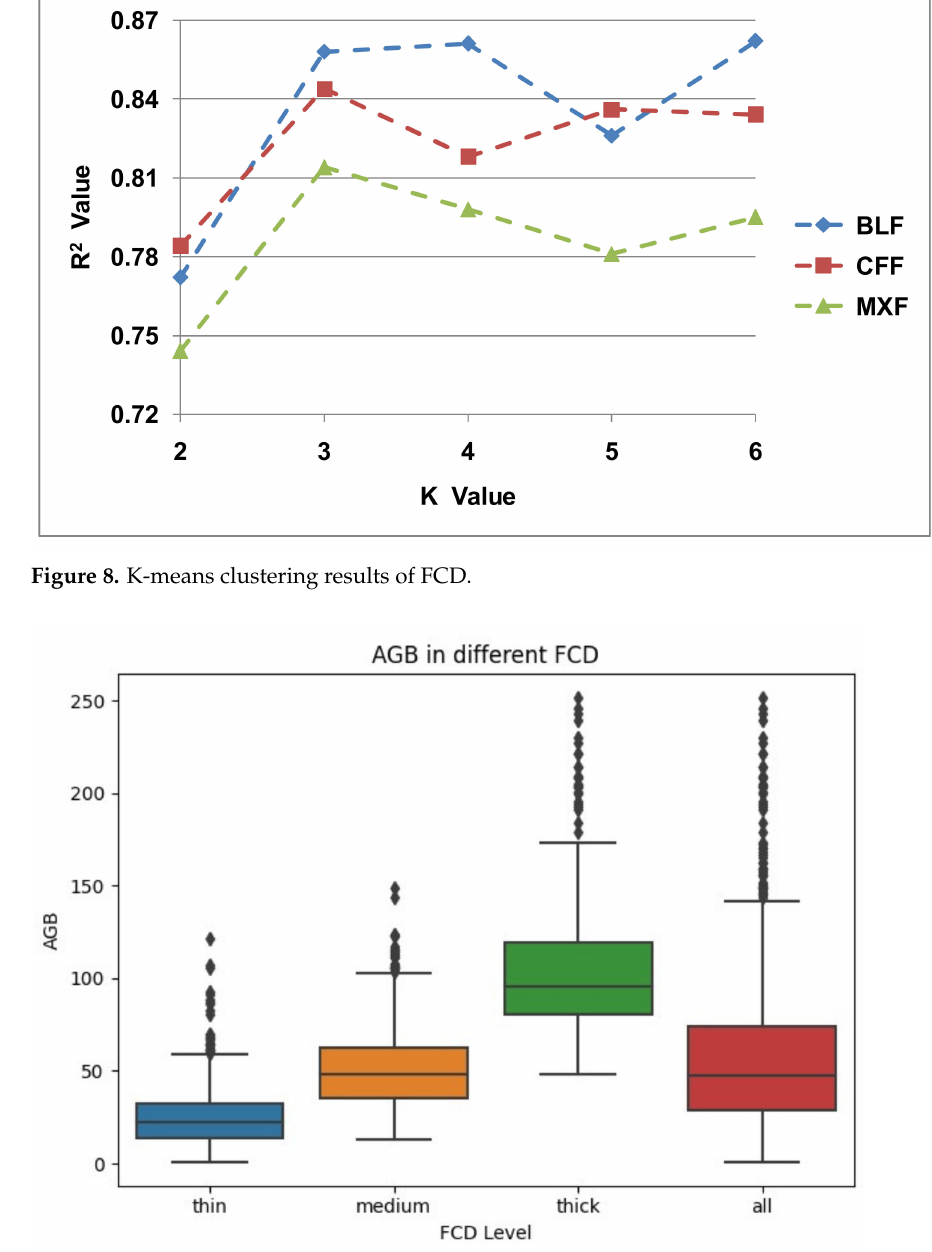
Figure 9. The biomass statistics of each level